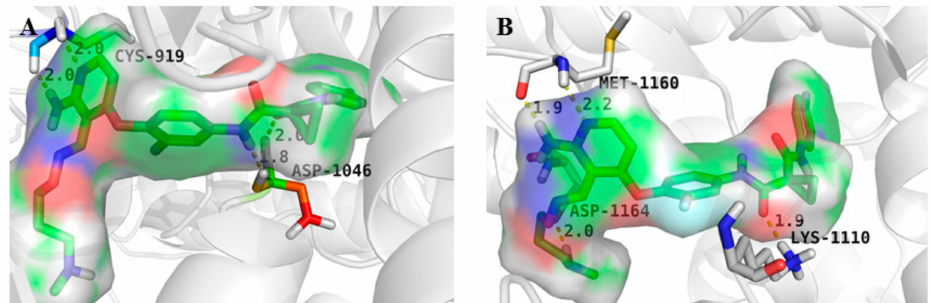
Figure 4. ( A ) The model of compound 1 binding to VEGFR-2 (PDB code: 3U6J); ( B ) The model of compound 1 binding to c-Met (PDB code: